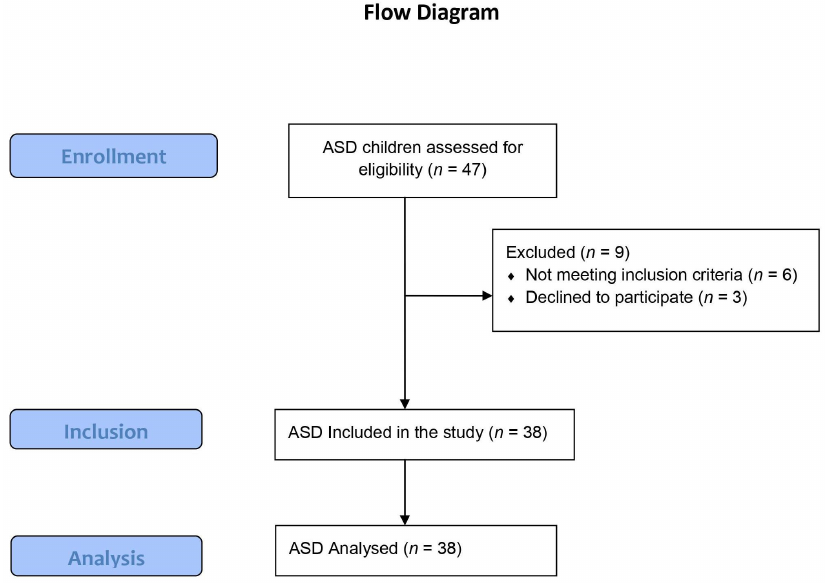
Figure 1. The flow diagram of the ASD children through the stages of the